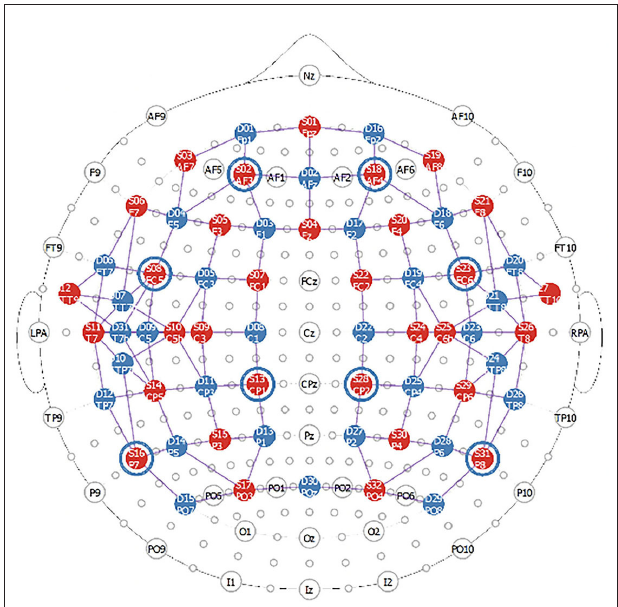
FIGURE 2 | FNIRS montage used in this study. The red circles represent the sources (32 in total) while the blue circles represent the detectors (31 in total). The blue circles around sources 2, 8, 13, 16, 18, 23, 28, 31 represent the location of the short channels which are connected to the last detector (detector